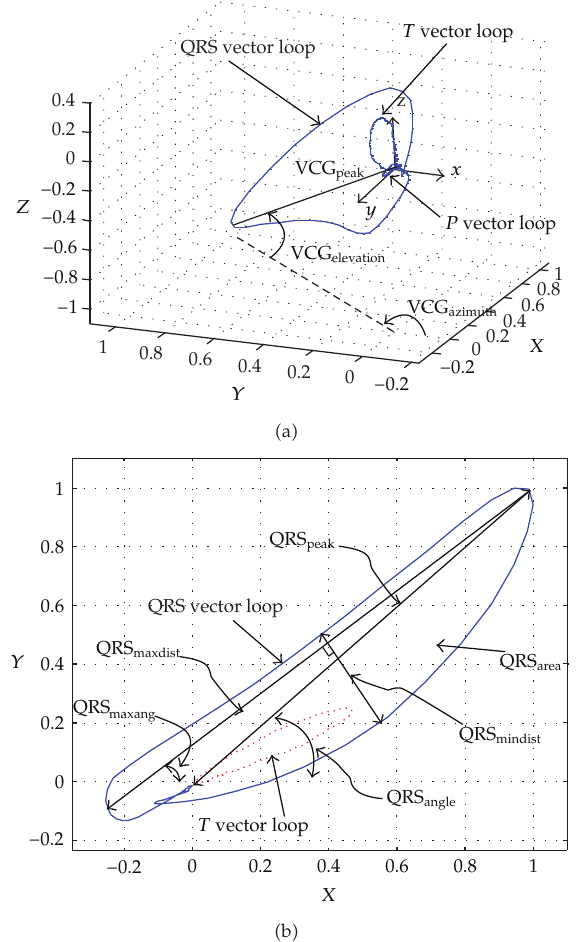
Figure 2: Feature extraction (cid:2) a (cid:3) from the dVCG in 3D space, and (cid:2) b (cid:3) from the QRS and T vector loops in the frontal